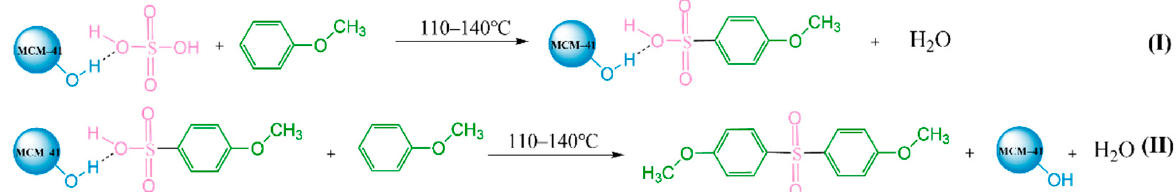
Figure 4. Adsorption reaction of anisole with SSA/MCM–41.